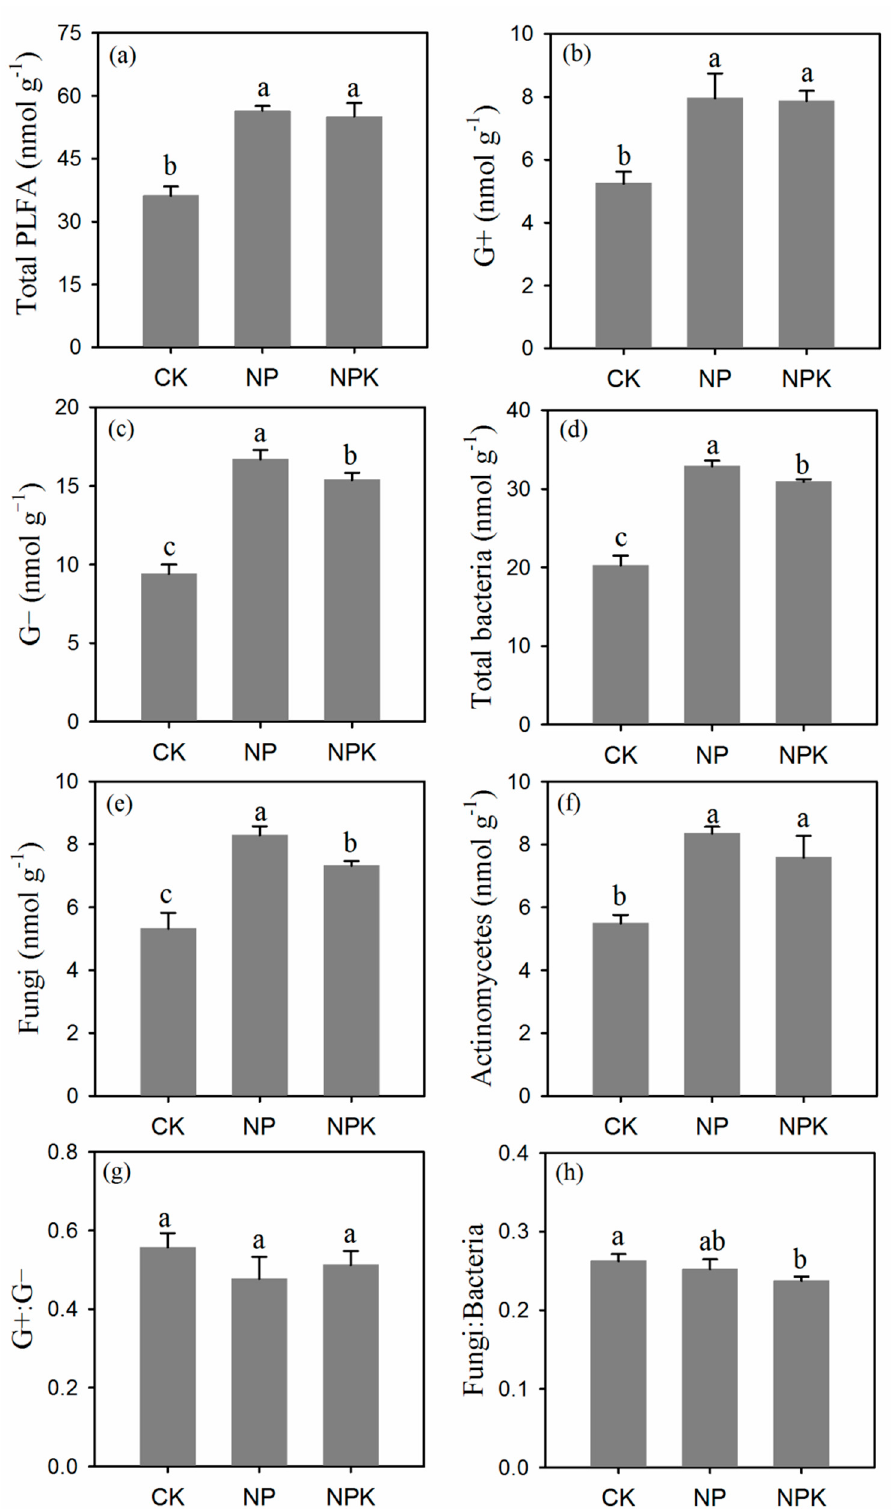
Figure 4. Comparisons of total PLFAs ( a ) and those for G + ( b ) and G − bacteria ( c ), total bacteria ( d ), fungi ( e ), actinomycetes ( f ), and the ratios of G + :G − bacteria ( g ) and fungi:bacteria ( h ) in soils from di ff erent long-term fertilizer treatments (CK, no fertilizer; NP, nitrogen and phosphorous fertilizer; NPK, nitrogen, phosphorus, and potassium fertilizer). Microbial abundance is expressed as nmol g − 1 . Vertical bars represent the standard error ( n = 3). Di ff erent lowercase letters indicate significant di ff erences among fertilizer treatments ( p < 0.05).